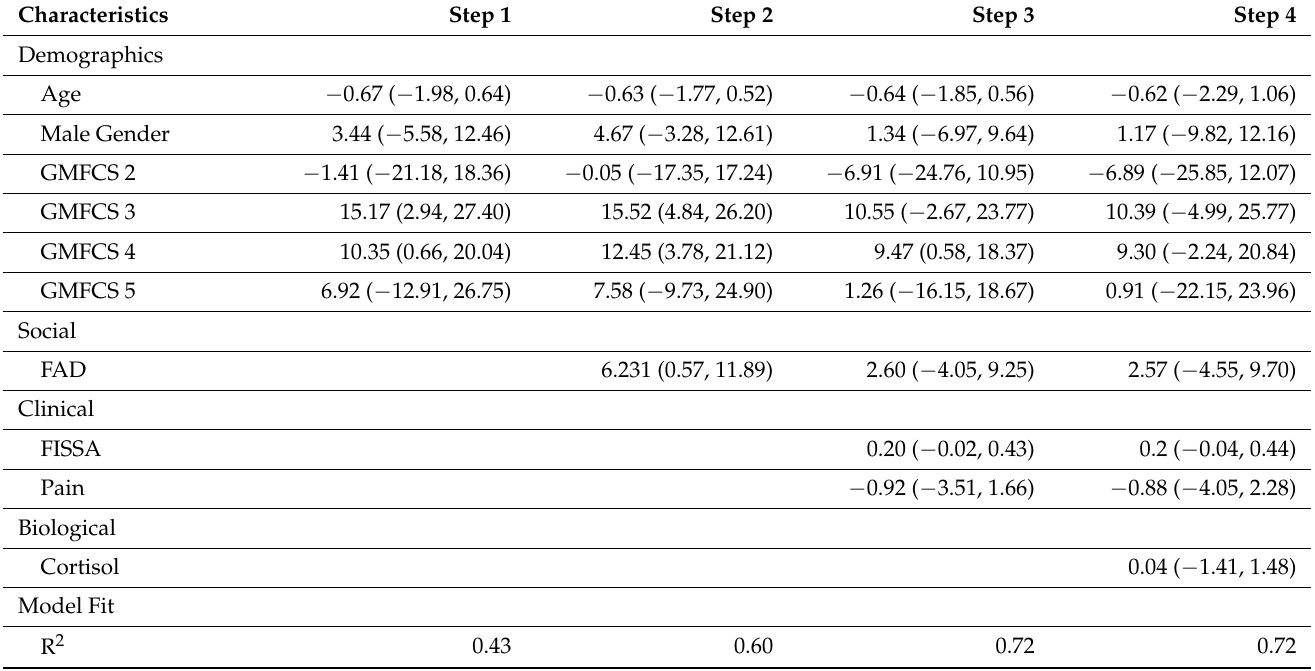
Table 7. Hierarchical regression model